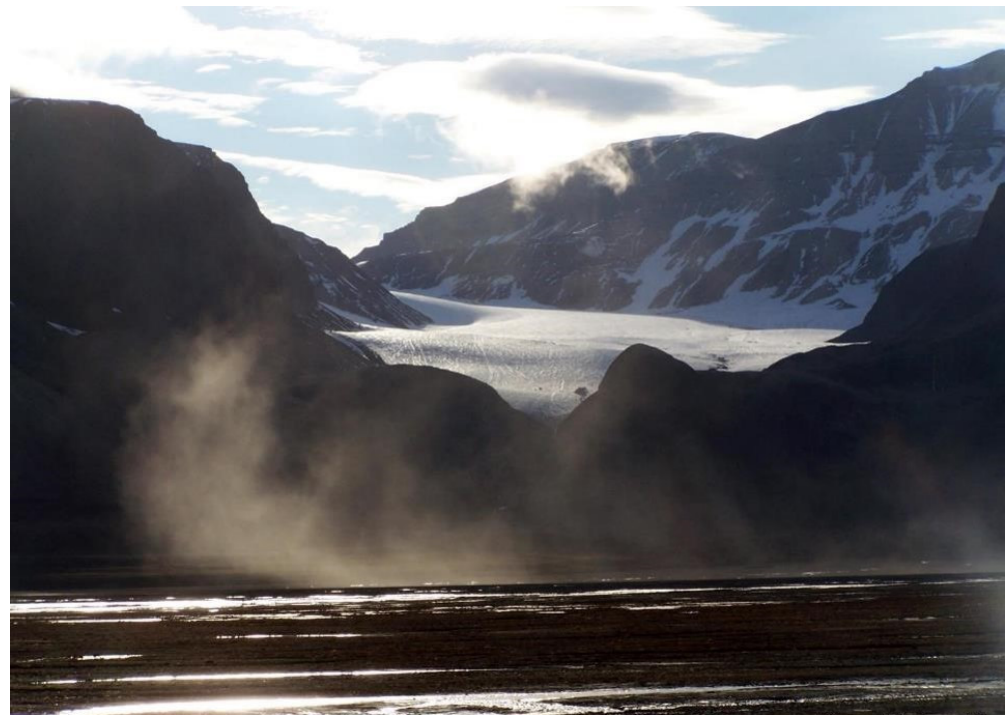
Figure 7. Uplift of fine mineral material in the forefield of the Sven glacier (Petuniabukta) (photo by T. Wawrzyniak).